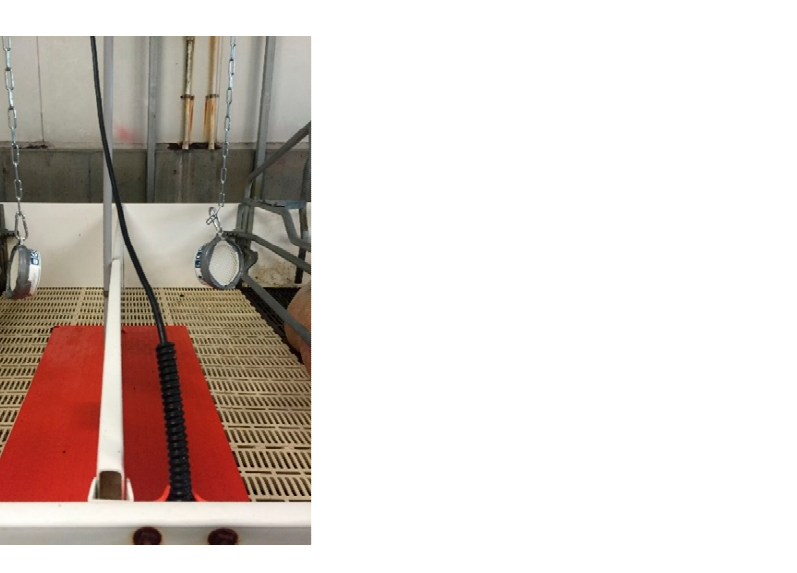
Figure 1. Placement of the Synthetic Olfactory Agonist diffuser blocks in the farrowing crate, above the heat mats.